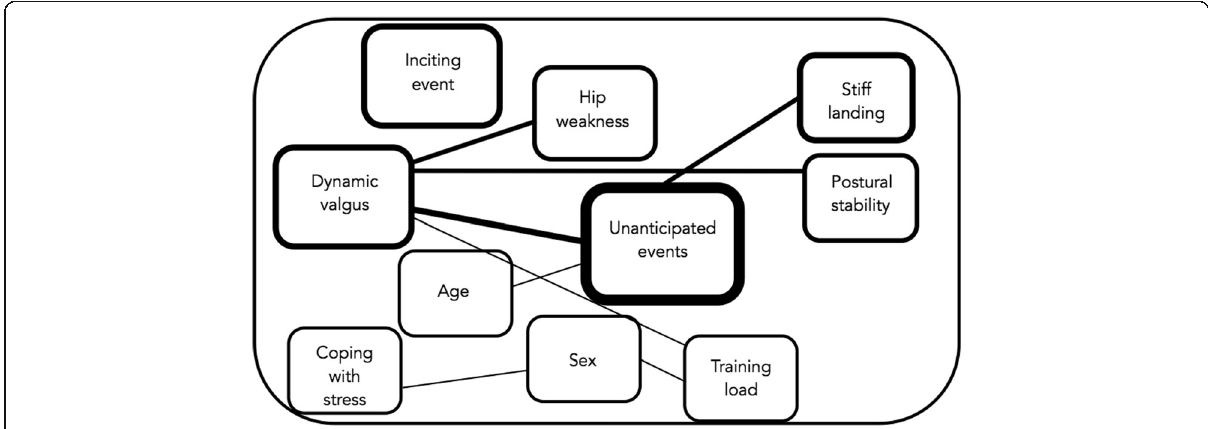
Fig. 1 Complex model for sports injury (example 15 year old female football player). The interaction between the various risk factors are presented. The variables that represent risk factors circled by darker lines have more interactions than variables circled by lighter lines (adapted from Bittencourt et al. (Bittencourt et al.,